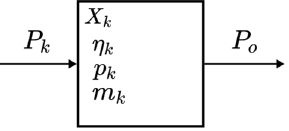
Figure 5. Parallel connection.